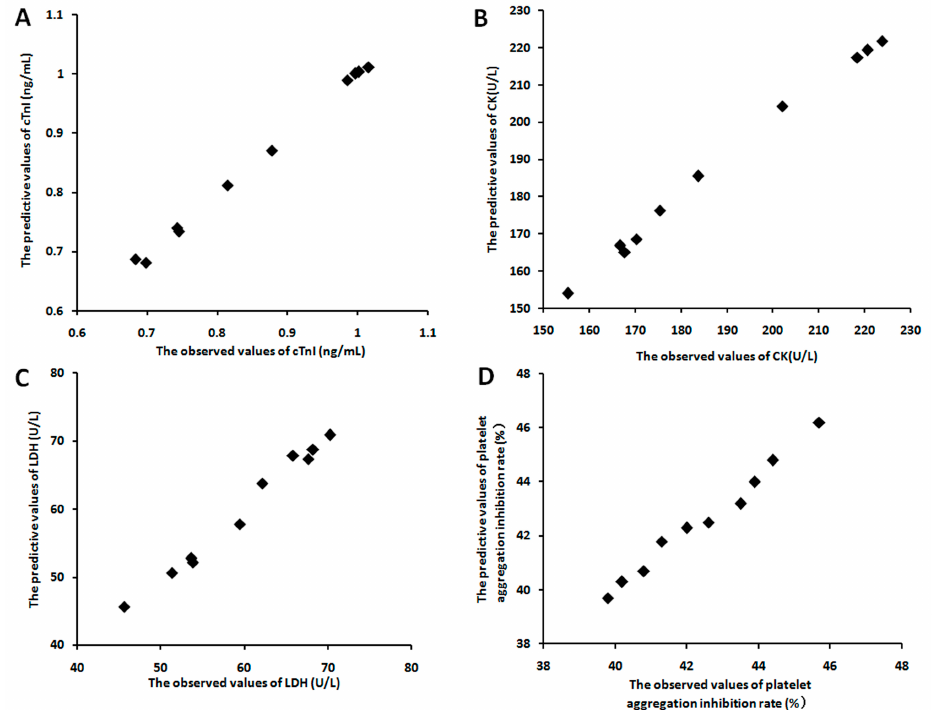
Figure 3. The diagram between the observed effects and the predictive effects in vitro studies in example 2. ( A ) cTnI; ( B ) CK; ( C ) LDH; ( D ) Platelet aggregation inhibition rate.